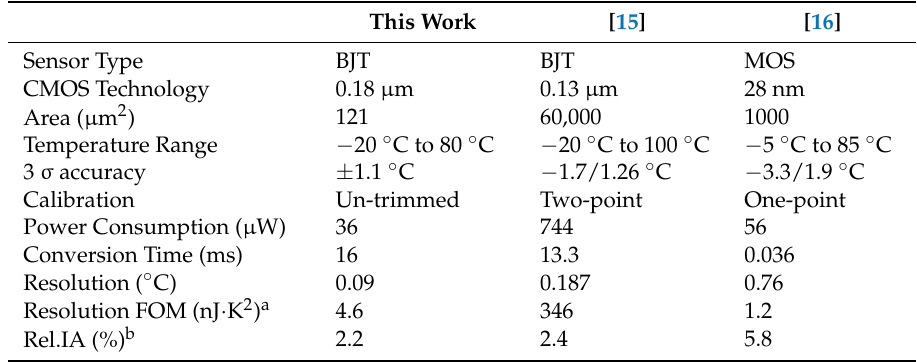
Figure 19. An image taken by part of the CIS (64 × 27), with constant current bias. Table 1. Summary of